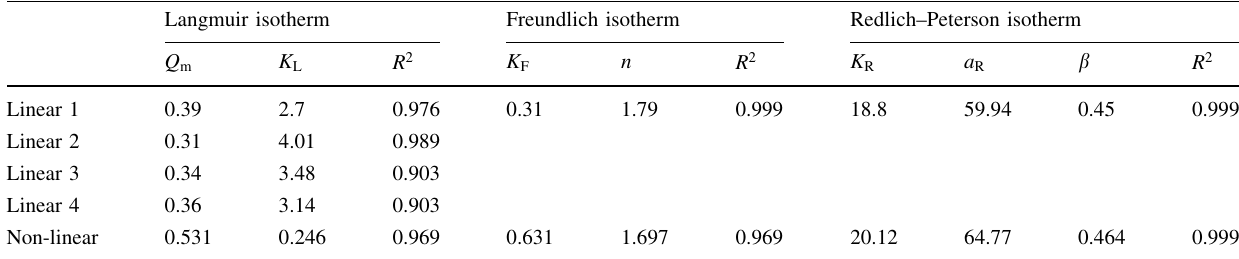
Table 2 Isotherm parameters obtained using the linear and non-linear method Langmuir isotherm